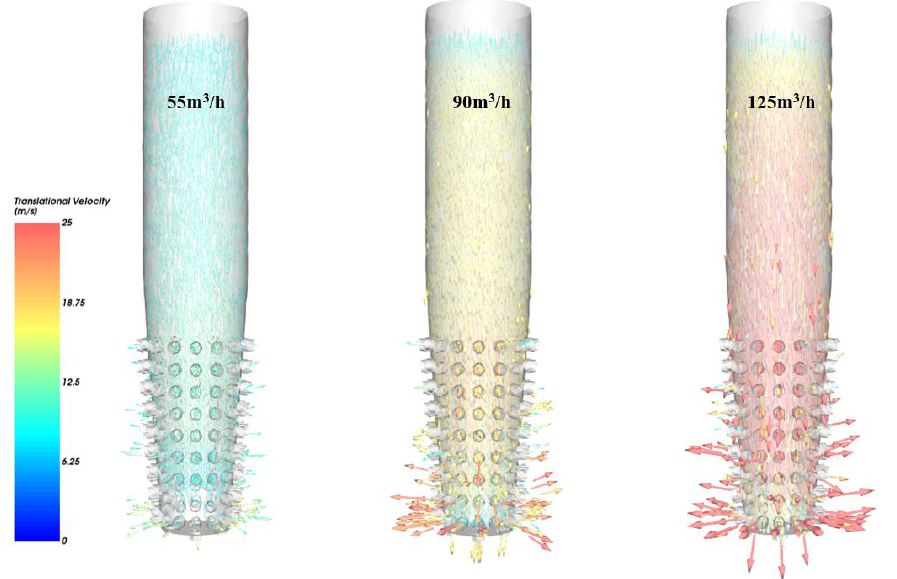
Figure 17. Velocity vector diagrams of LCMs under the action of low, medium and high displace- ment fluids.